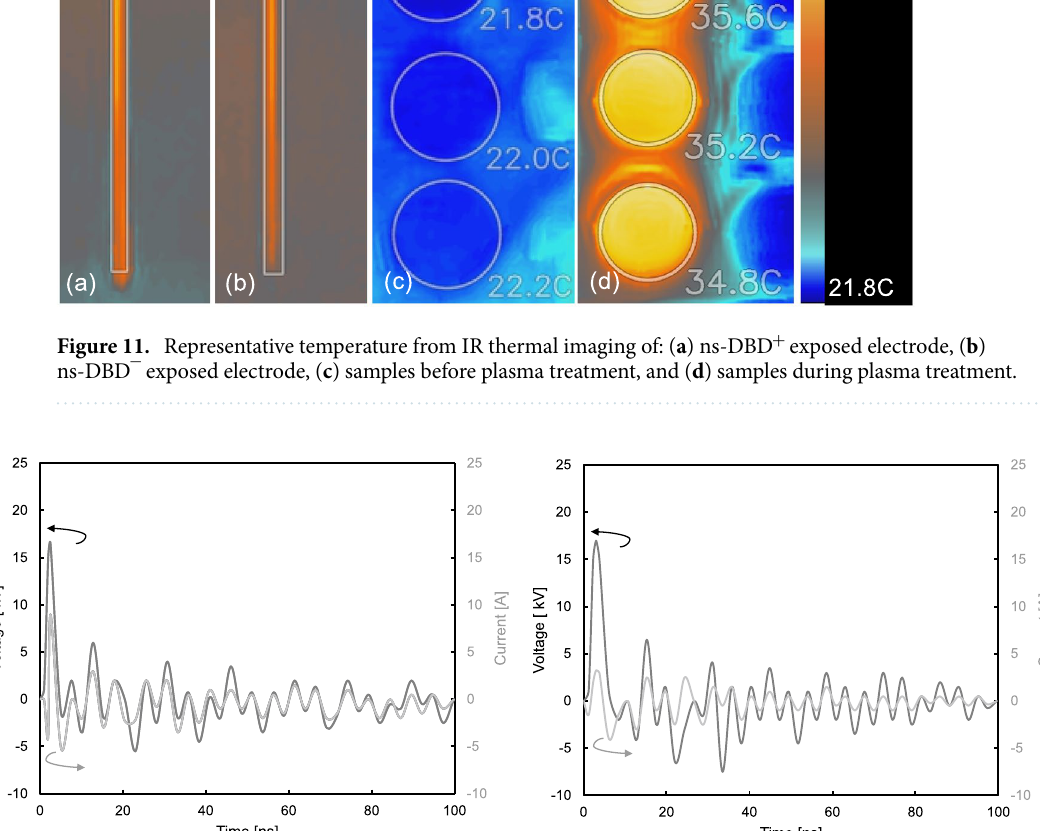
Figure 12. Voltage and current characteristics of the ns-DBD